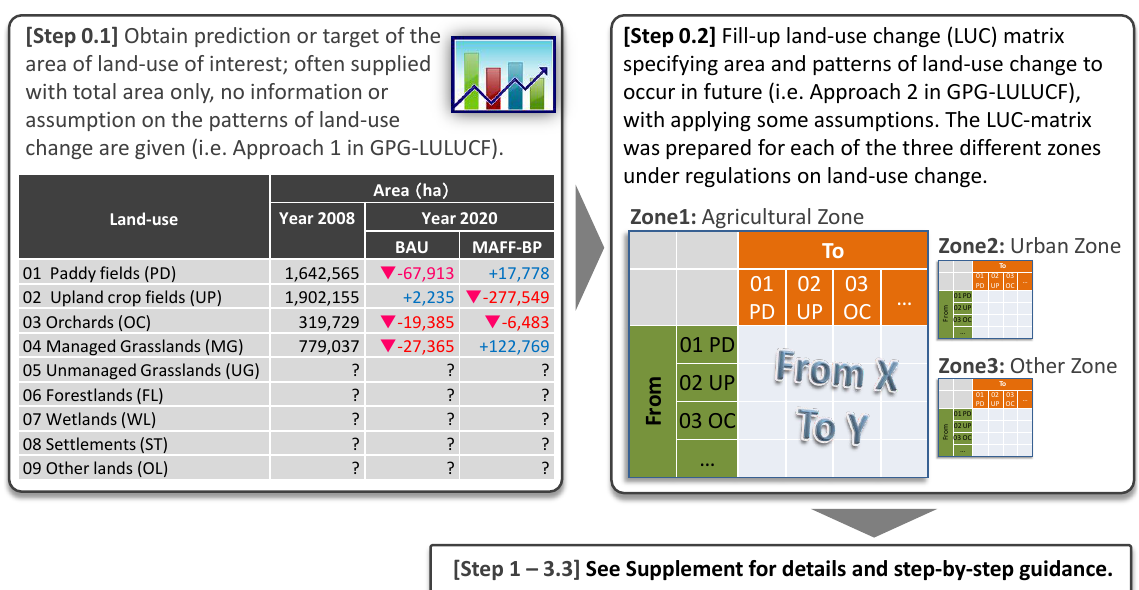
Figure 2. Schematic illustration of the beginning part of the procedures developed to create spatially explicit future land-use map based on the latest land-use map and land-use change matrices that contains information on land-use conversions in the future.